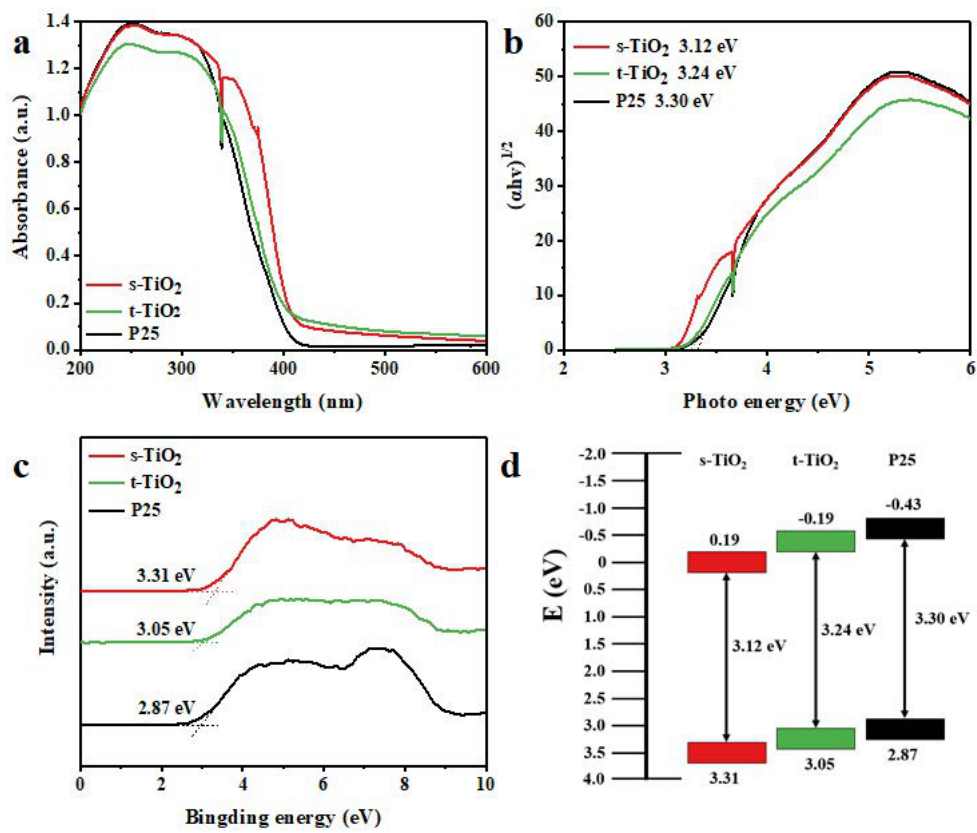
Figure 5. ( a ) UV-Vis DRS spectra, ( b ) Tauc bandgap diagram, ( c ) VB XPS spectra, and ( d ) band structure alignments of s-TiO 2 , t-TiO 2 , and